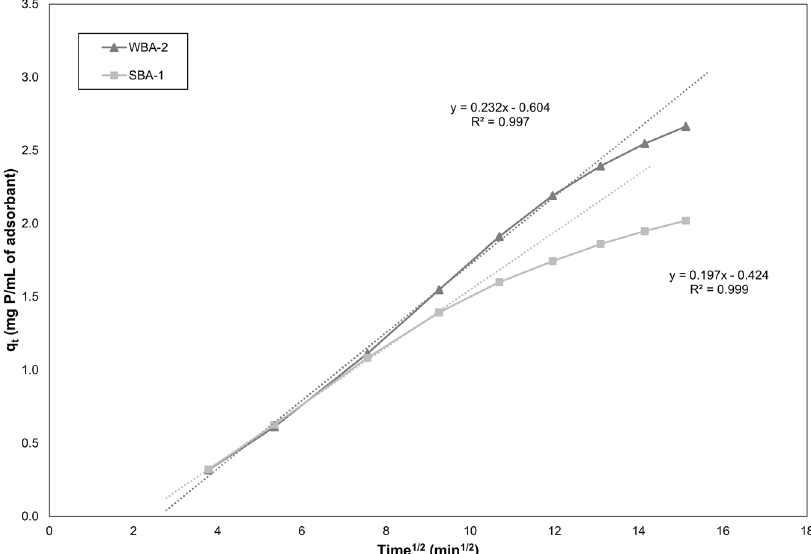
Fig. 4 Intra-particle diffusion plots. Adsorption uptake (mg P/mL of HAIX-Nano) vs time 1/2 (min 1/2 ) for WBA-2 and